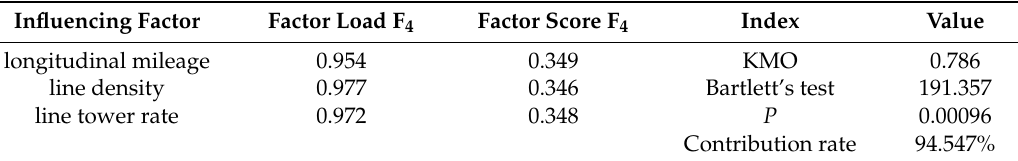
Table 5. Factor analysis of number of lines.